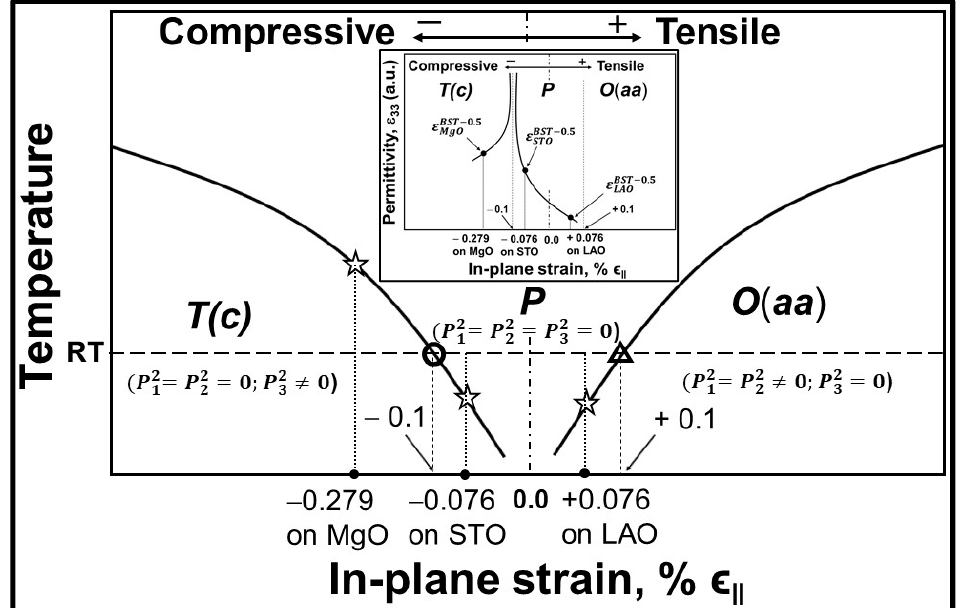
Figure 4. Schematic temperature (T) in-plane strain ( (cid:101) || ) phase diagram (not-to-scale) for single domain and epitaxial (100) BST-0.5 film under in-plane compressive and tensile strains on cubic substrates. The theoretically calculated Curie–Weiss (CW) temperatures, represented by open circle ( O ) at % compressive (cid:101) || of − 0.1 and open triangle ( ∆ ) at % tensile (cid:101) || of +0.1, correspond to T(c)-P phase boundary and P − O ( aa ) phase boundary, respectively, at RT. The open stars ( ☆ ) correspond to the relative CW temperatures of nanocrystalline epi-BST-0.5 films. The inset (not-to-scale) shows the theoretically predicted anomaly in (cid:101) || -dependent, out-of-plane dielectric permittivity ( ε 33 or ε / ⊥ ) of single domain film at RT in the vicinity of the T(c) - P phase boundary; note, the tails of ε and the relative position coordinates ( (cid:101) || , ε / ⊥ ) of nanocrystalline epi-BST-0.5 films, denoted as solid circles ( • ) , are a guide to the eye.